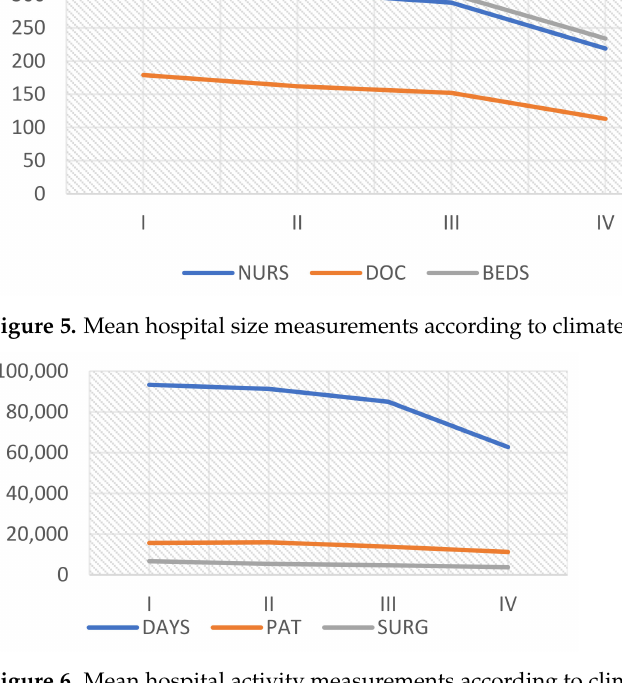
Figure 6. Mean hospital activity measurements according to climate